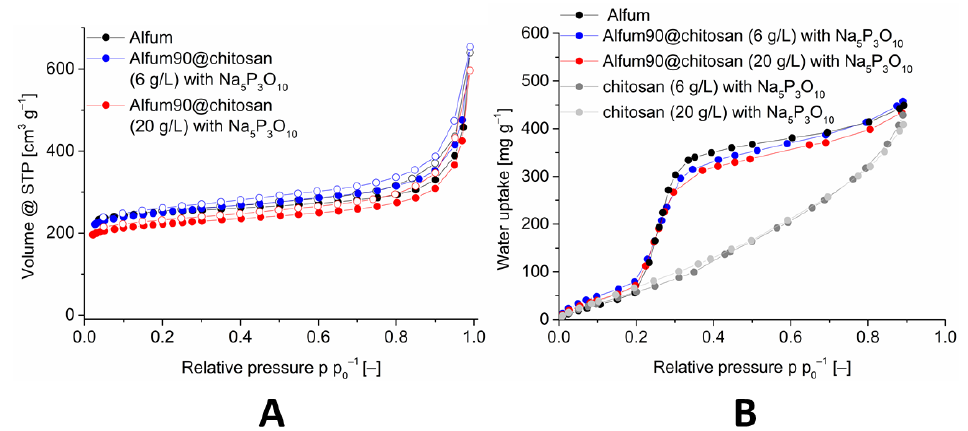
Figure 5. Image ( A ): Nitrogen sorption (77 K) isotherm of Alfum90@chitosan composites with different chitosan concentrations, in comparison with Alfum. Image ( B ): Water adsorption (293 K) isotherms of Alfum90@chitosan composites with different chitosan concentrations, in comparison with Alfum and crosslinked chitosan. The isotherms for 60 and 80 wt-% Alfum@chitosan are shown in Figures S29 and S37 (Supplementary Information).